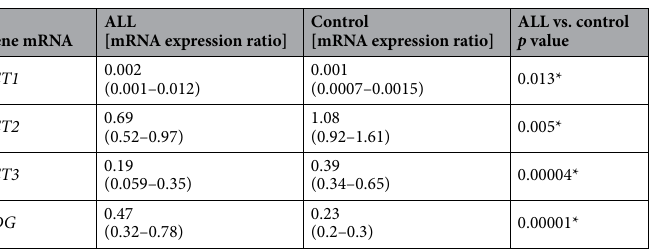
Table 3. Expression of TET1 , TET2 , TET3 and TDG mRNA in the healthy controls and ALL patients ( * p < 0.05).